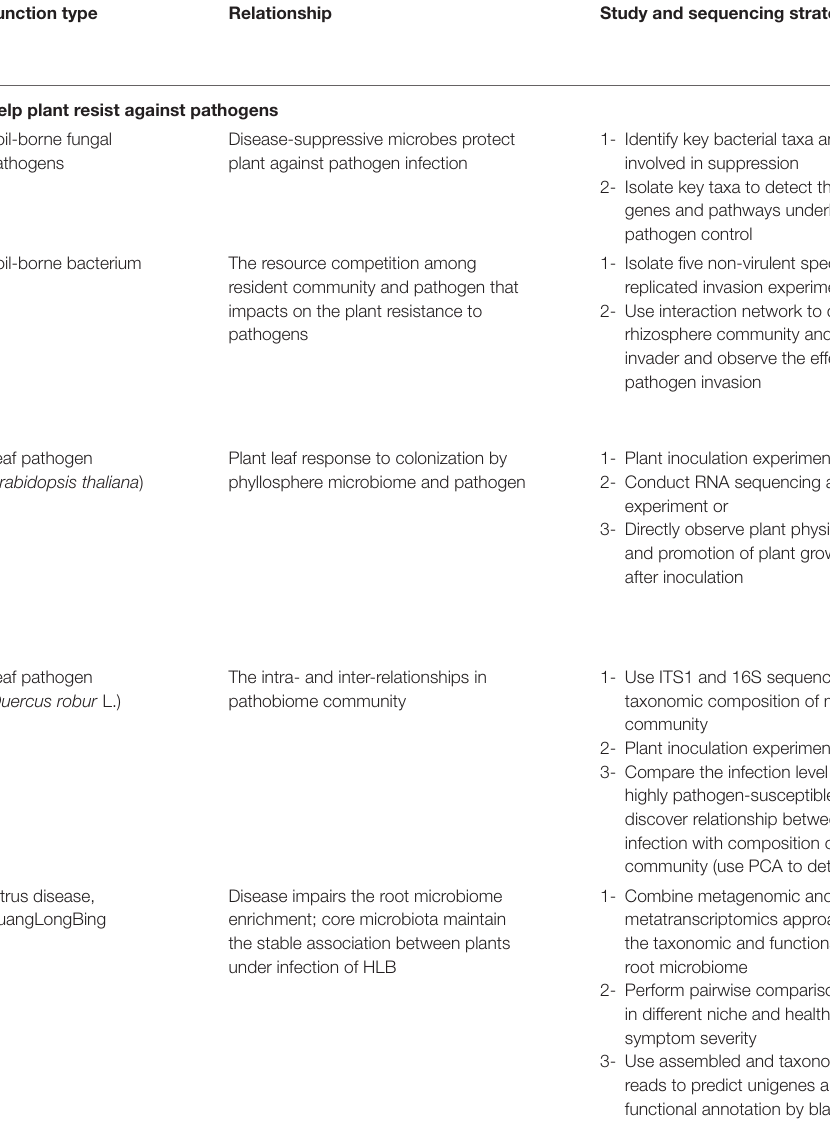
TABLE 1 | The methods and strategies of functional association study in